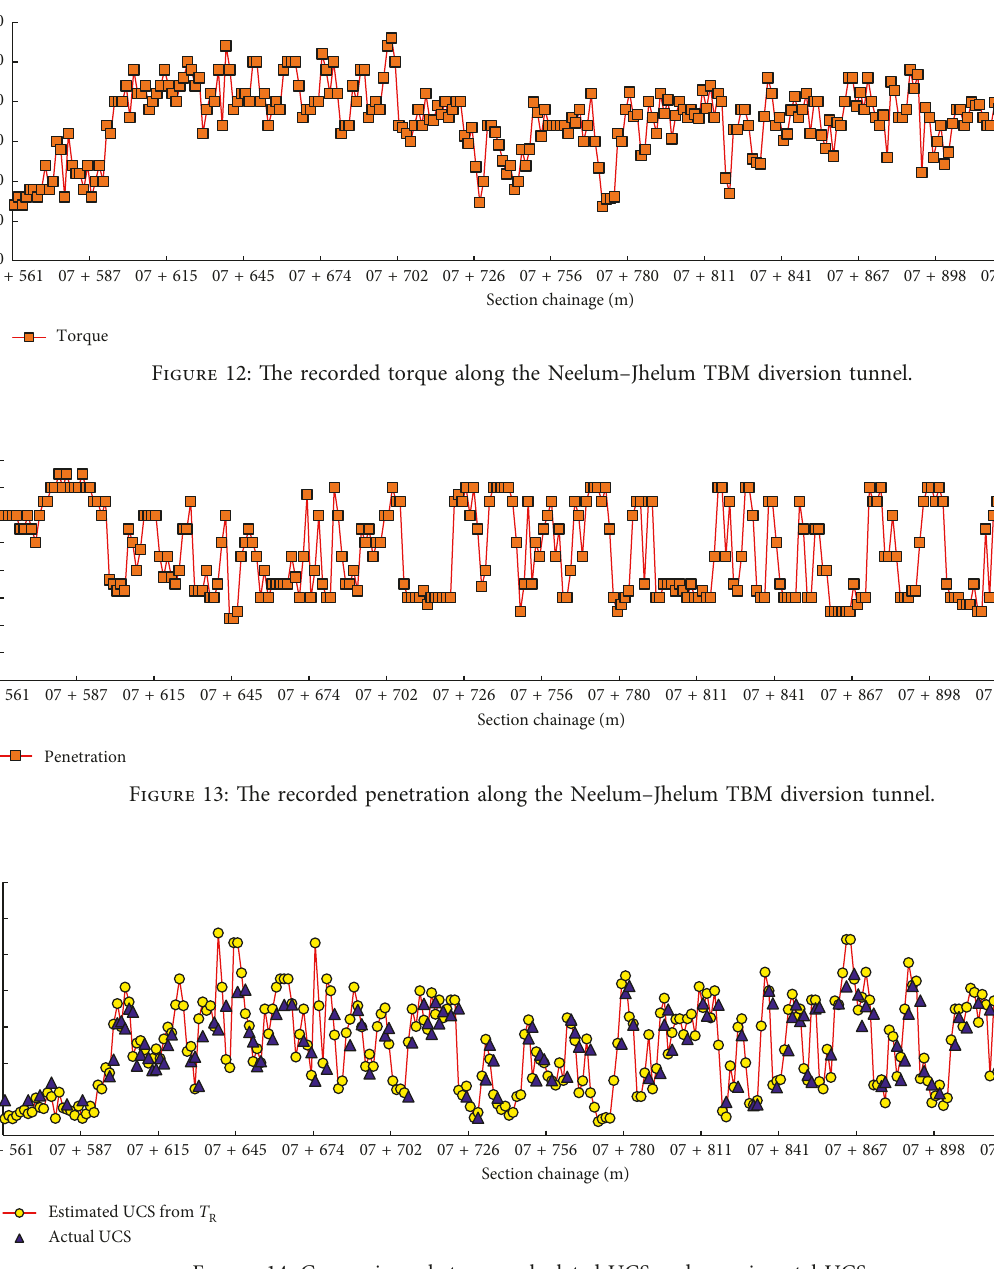
Figure 14: Comparisons between calculated UCS and experimental UCS.